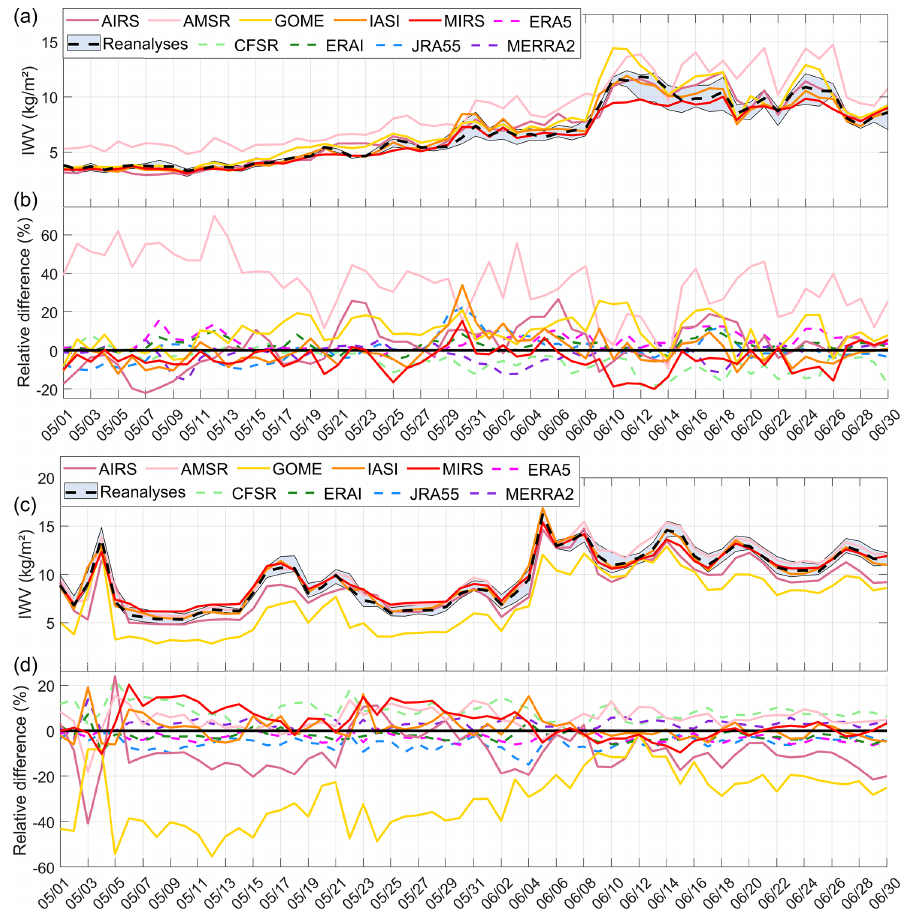
Figure 8. Daily time series of area-averaged IWV for the central Arctic (a, b) and open-ocean (c, d) areas for different products as indicated in the legends. The relative difference is given with respect to the reanalysis median (CFSR, ERAI, JRA55, MERRA2; dashed black line). The shaded area indicates the minimum and maximum values of the